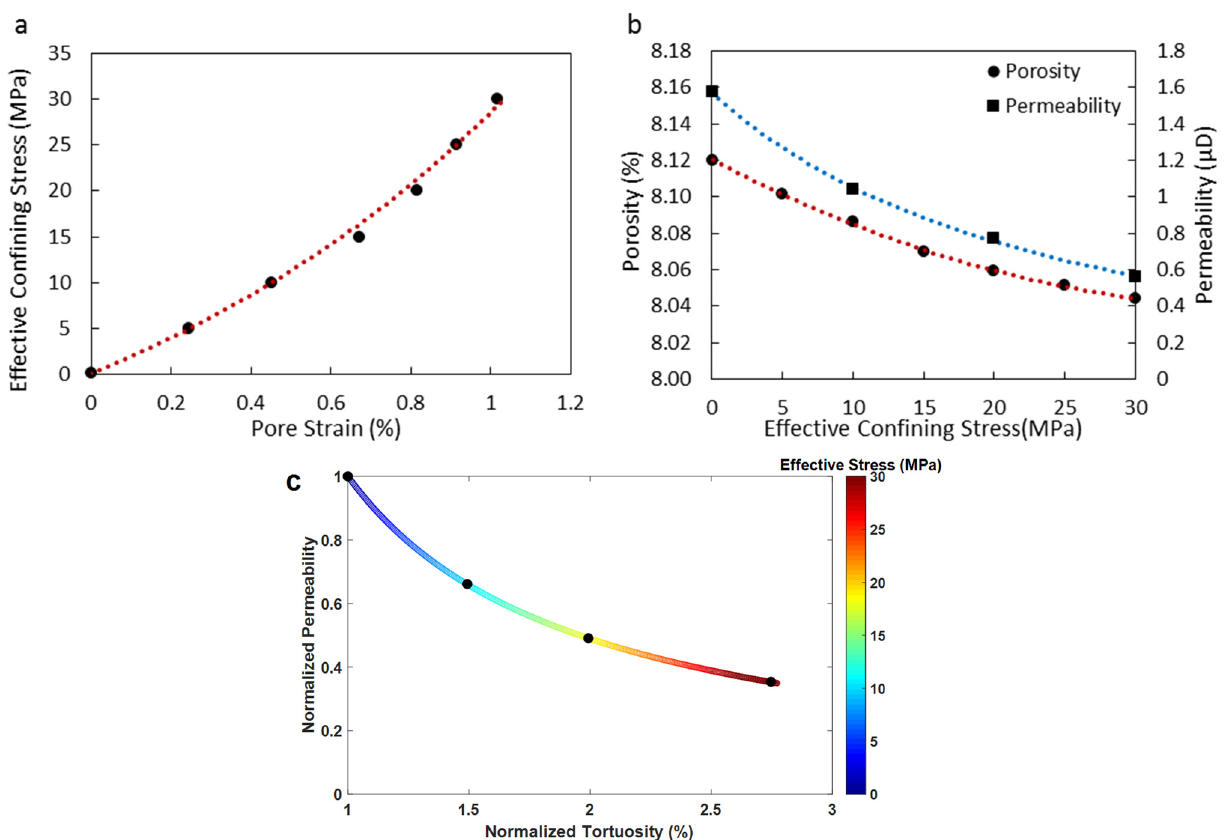
Figure 4. Core-scale experimental results representing the stress dependency of structural and single-phase flow properties of the intact rock: ( a ) effective stress versus pore strain plot, ( b ) stress-dependent porosity and absolute permeability, and ( c ) normalized permeability versus normalized tortuosity with effective stress.